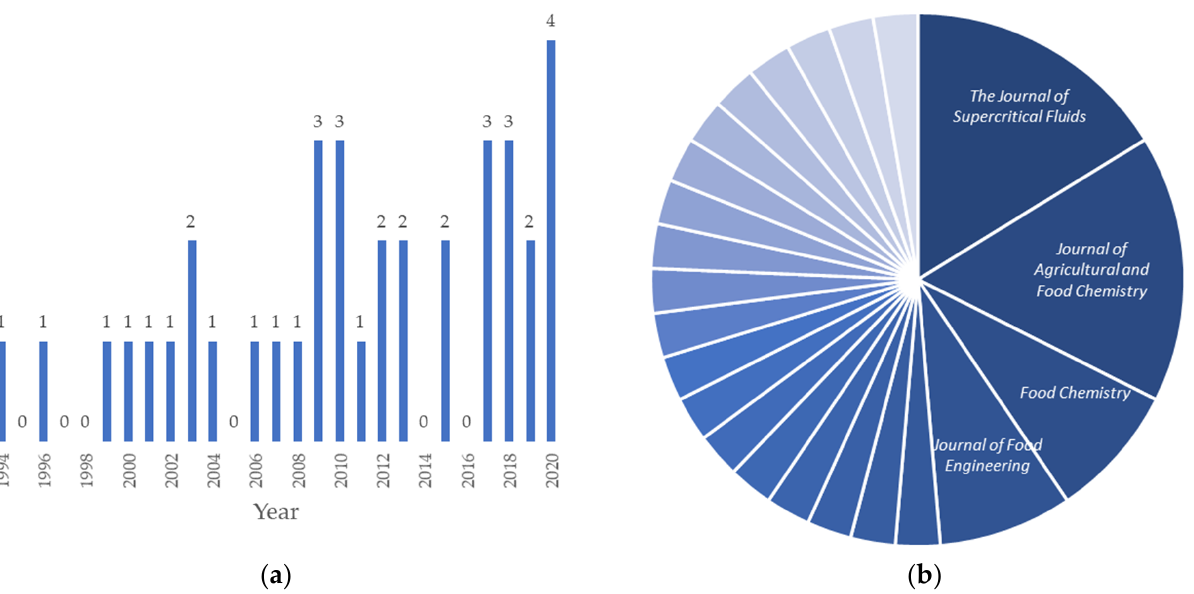
Figure 1. Number of studies studying the supercritical fluid extraction of tomato through the years ( a ) and the most common journals where they appear ( b ). Search was performed in Scopus using the keywords “supercritical extraction tomato”.